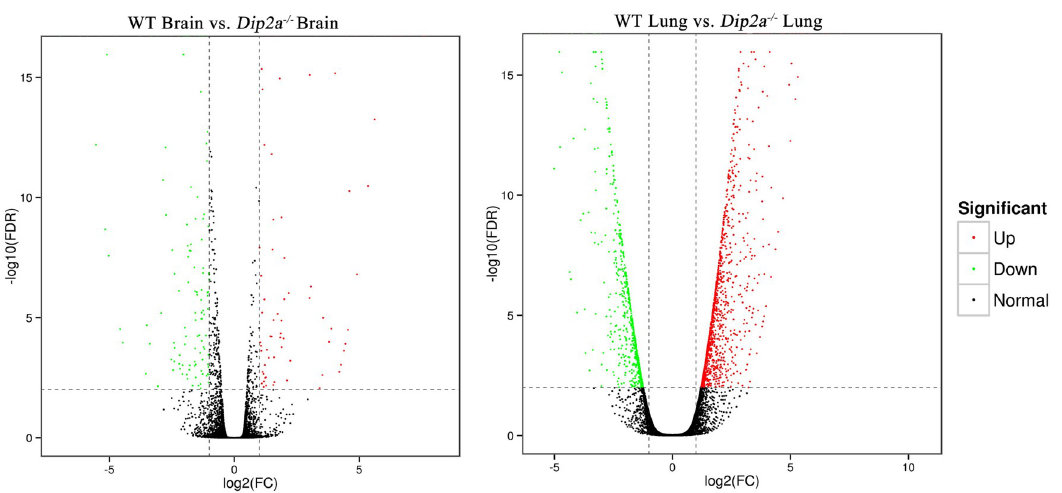
Fig 2. Differentially expressed genes volcano map. (a) WT brain vs. Dip2a -/- brain. (b) WT lung vs. Dip2a -/- lung. The red and green dots in the figure represent up-regulated and down-regulated differentially expressed genes respectively.